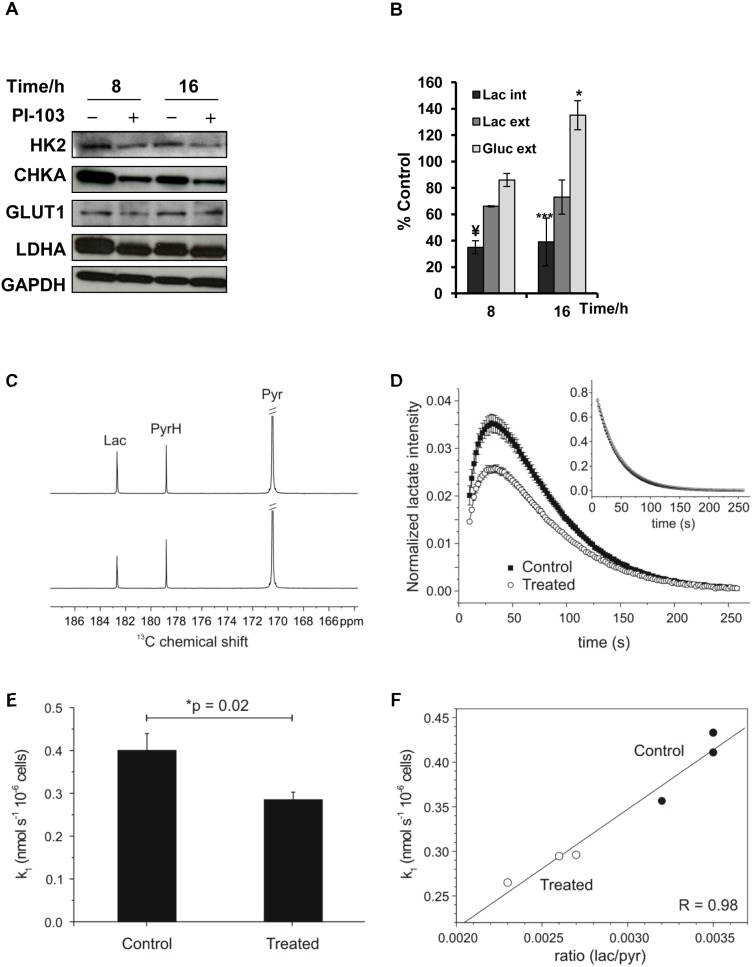
Investigation of mechanisms underlying NMR-detected changes in the levels of choline metabolites and lactate following treatment of SF188 pediatric glioblastoma cells with PI-103 (5×GI50).(A) Representative Western blots showing changes in protein expression levels of enzymes involved in choline metabolism (CHKA) and glucose metabolism including: GLUT1, HK2 and LDHA, at selected time points post treatment with PI-103. GAPDH was used as a loading control. (B) Quantitative measurement of 1H-NMR detected percentage changes in the levels of lactate (Lac, internal & external) and glucose (external) at selected time points post treatment with PI-103 relative to controls, 8 hours n = 2. Results are expressed as percentage of treated to control and presented as the mean ± SD (error bars). Statistically significant different from the control *p≤0.05, **p<0.01, †p≤0.005, ‡p<0.0005; two-tailed unpaired t test was used for all comparisons. (C) Sum 13C-NMR spectra over the entire time-series with peaks corresponding to lactate, pyruvate and pyruvate hydrate in either control (top) or PI-103 treated groups (bottom), from which a decrease in the lactate peak intensity can be appreciated. (D) The time-series of the lactate peak integral normalized to cell number with inset showing the pyruvate time dependence. (E) A decrease in the rate of pyruvate-lactate exchange rate constants was detected in PI-103 treated cells compared to controls. (F) A decrease in the area under the curve was also observed in PI-103 treated cells compared to controls, p = 0.005.